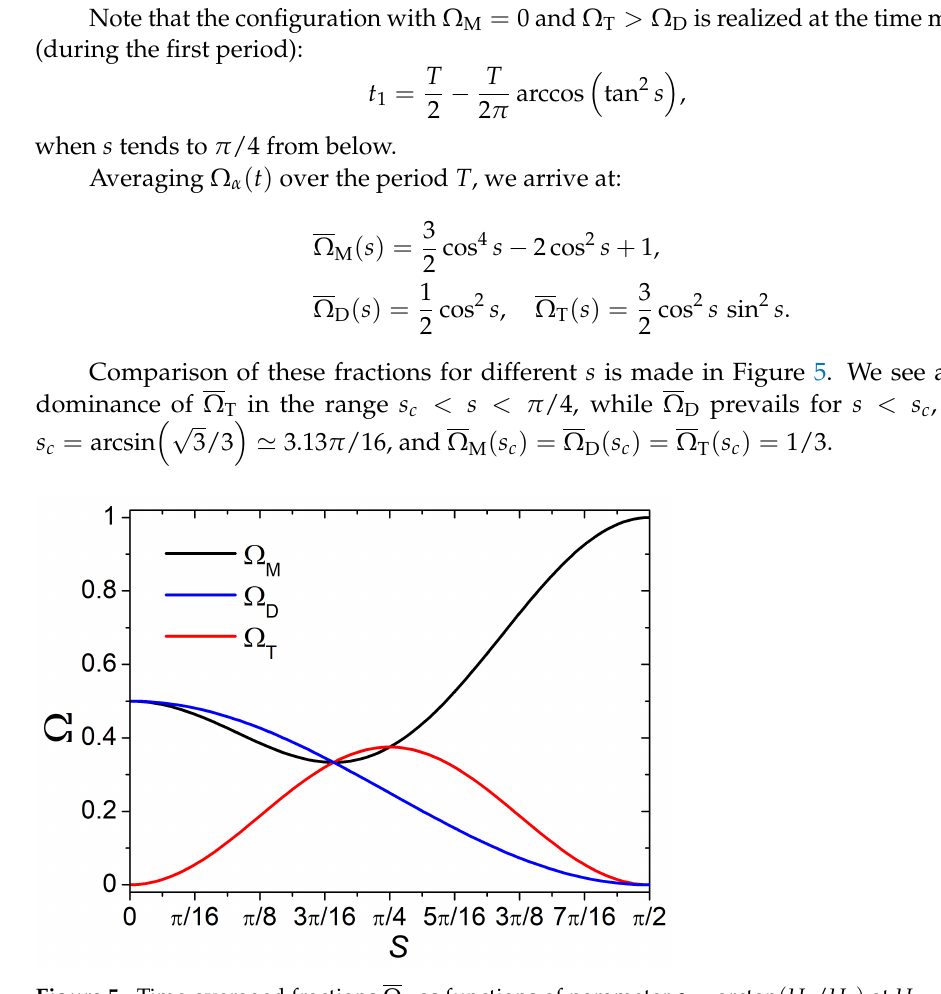
Figure 5. Time-averaged fractions Ω α as functions of parameter s = arctan ( U 2 / U 1 ) at U 3 = 0. Additionally, let us indicate the changes in the energy spectrum when ˆ H 0 (cid:54) = 0. Given ˆ H = diag ( µ , µ , µ ) , we get a shift in (45): λ 0 leads to rescaling: λ 1 = J e − a , λ 2 = 0, λ 3 = − J e a (see (46)). Dynamics in these cases will